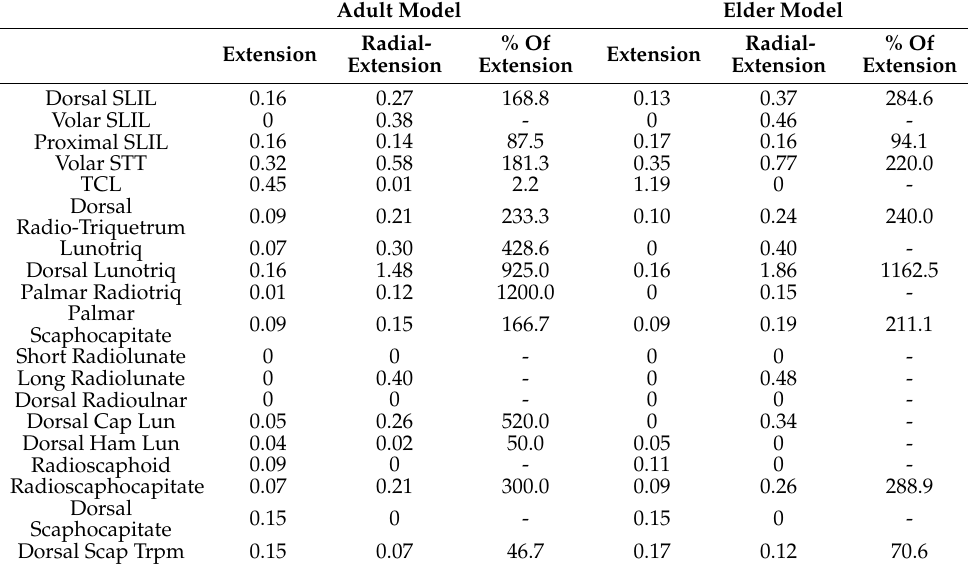
Table A2. Forces in the ligaments attached to the scaphoid, lunate and radius bones in extension and radial-extension models in the adult and elder simulations. The percentage of variable in the radial-extension model in relation to the extension model is calculated and presented as “ % of Extension